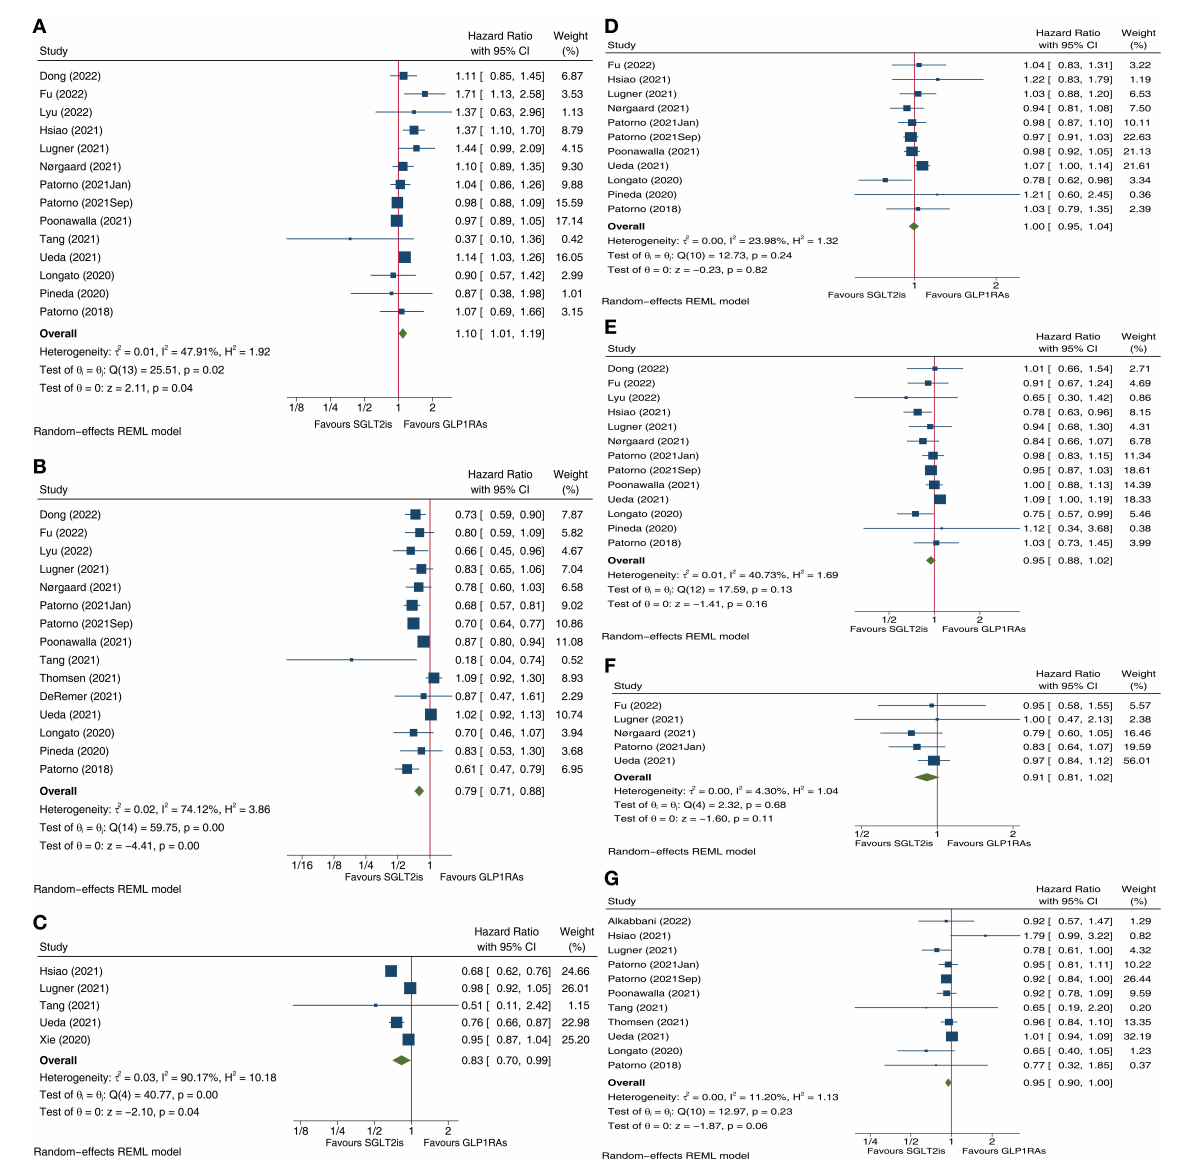
FIGURE1 Forest plots of meta-analysis on stroke (A) , hospitalization for heart failure (B) , composite kidney outcome (C) , major adverse cardiovascular events (D) , myocardial infarction (E) , cardiovascular death (F) , and all-cause mortality (G) . SGLT2is, sodium-glucose cotransporter 2 inhibitors; GLP1RAs, glucagon-like peptide 1 receptor agonists; CI, confidence